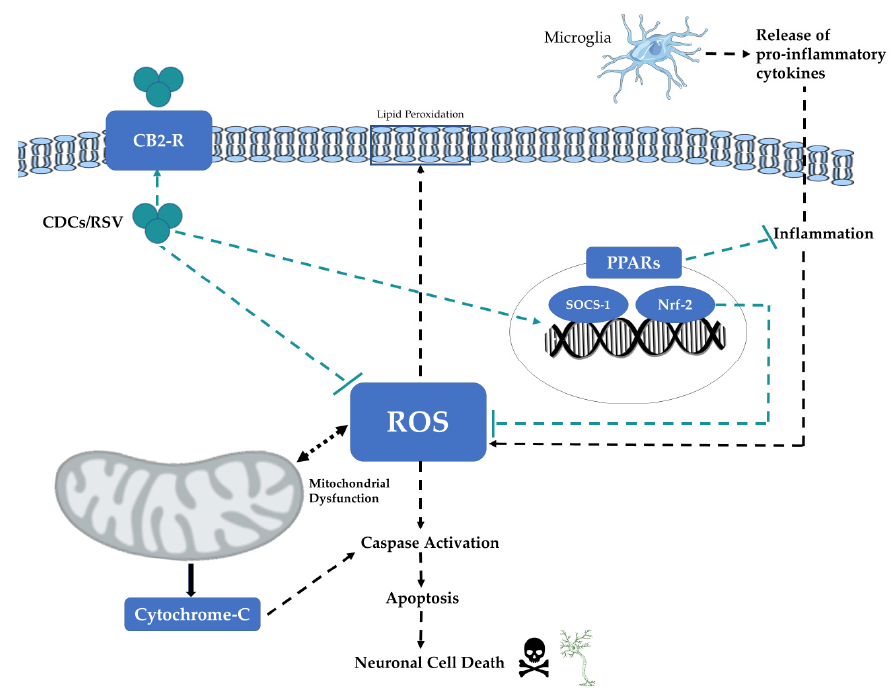
Figure 3. Schematic summary of the potential neuroprotective mechanisms of CDCs or RSV in neurons following induction of PD. Redox stress and the production of reactive oxygen species (ROS) can damage mitochondria and this can further exacerbate ROS production and trigger the release of mitochondrial cytochrome-c and induction of apoptosis. ROS also damages cellular protein targets and induces lipid peroxidation. ROS levels are also elevated in response to inflammatory mediators released by microglia and astrocytes. CDCs and RSV are neuroprotective and scavenge free radicals to reduce the levels of ROS and associated cellular redox stress. CDCs or RSV promotes the activity of PPARs, SOCS-1, and Nrf-2 to reduce inflammation and the induction of ROS.